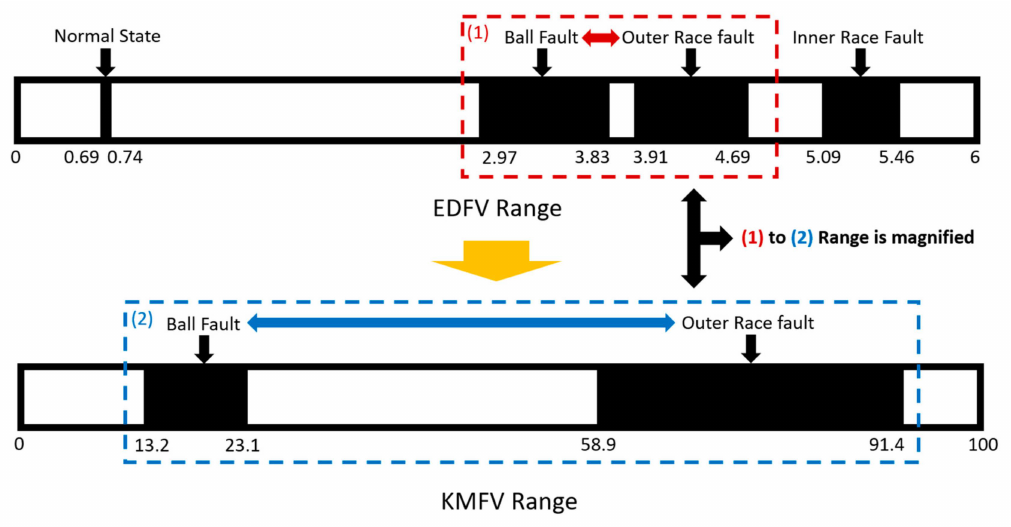
Figure 12. The schematic diagram of the hierarchical structure in Method 2.